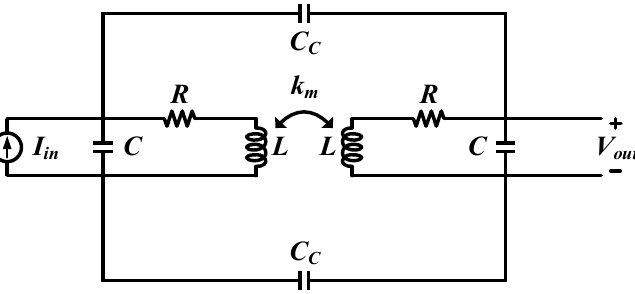
Figure 7. Model of electromagnetic coupling and the capacitively coupling transformer.